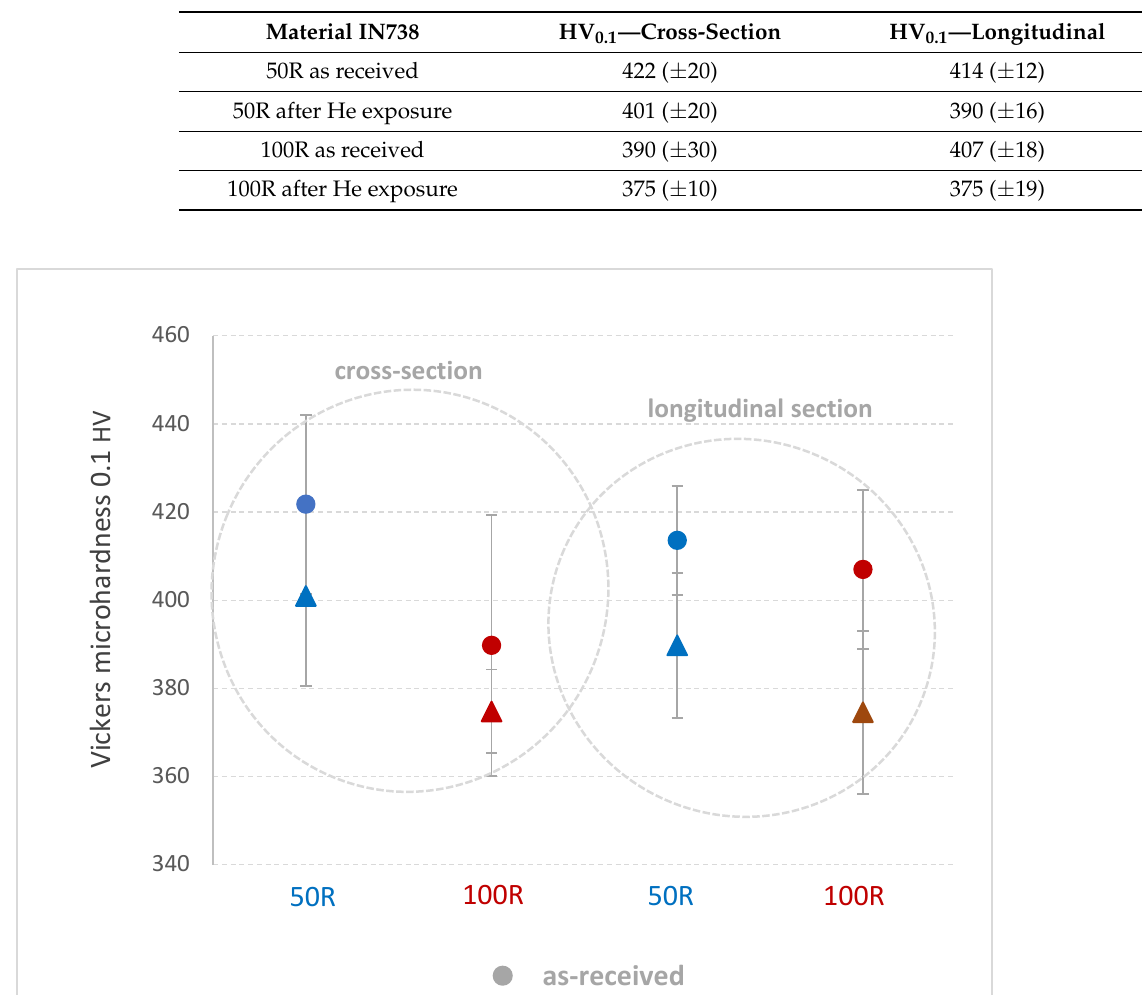
Table 3. Vickers microhardness HV0.1 in the longitudinal direction and cross-section of specimens before and after He exposure.